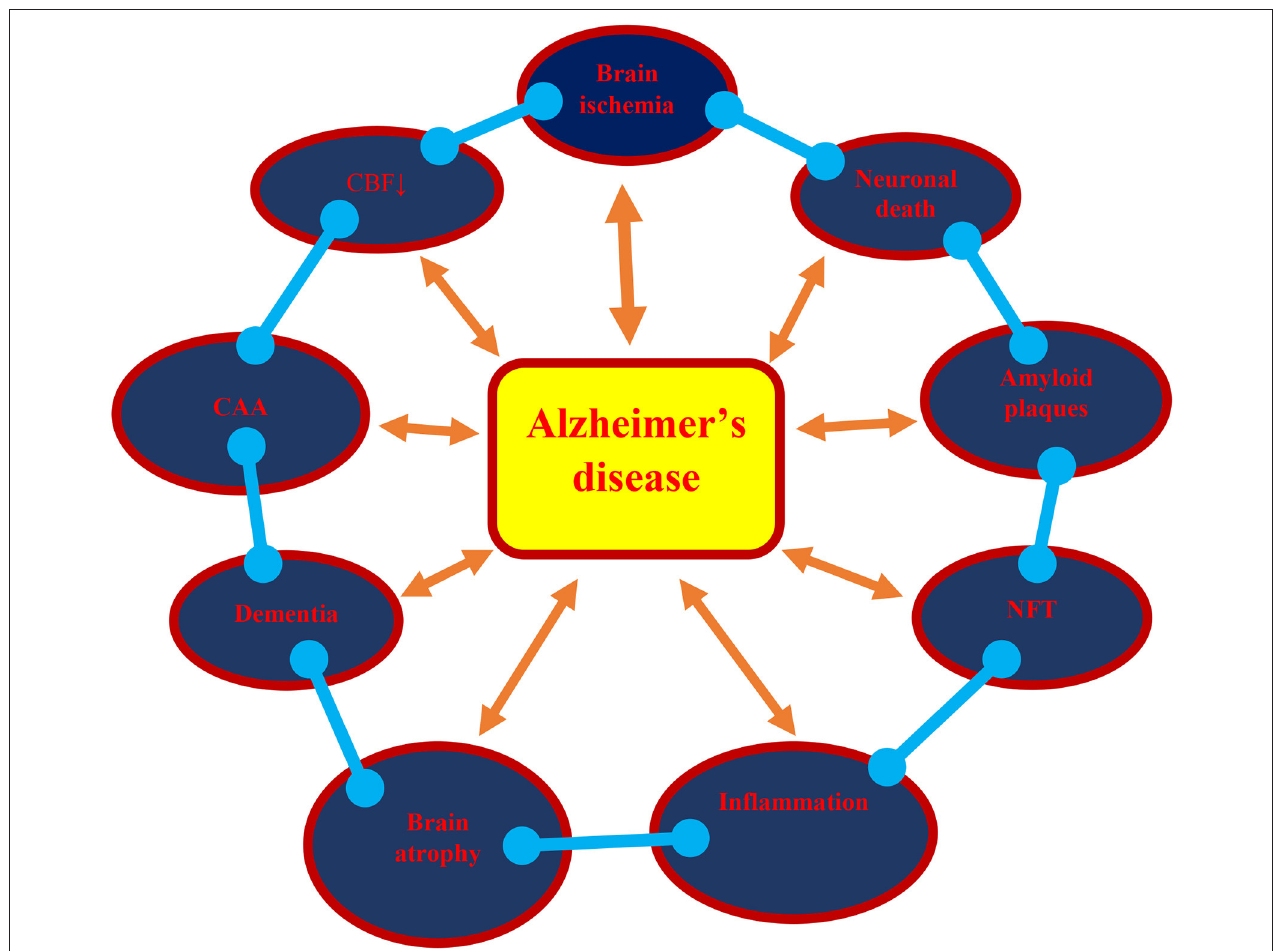
FIGURE 1 | A possible vicious circle in the development of Alzheimer’s disease as a result of brain ischemia. ↓ , decrease; CAA, cerebral amyloid angiopathy; CBF, cerebral blood flow; NFT, neurofibrillary tangles.